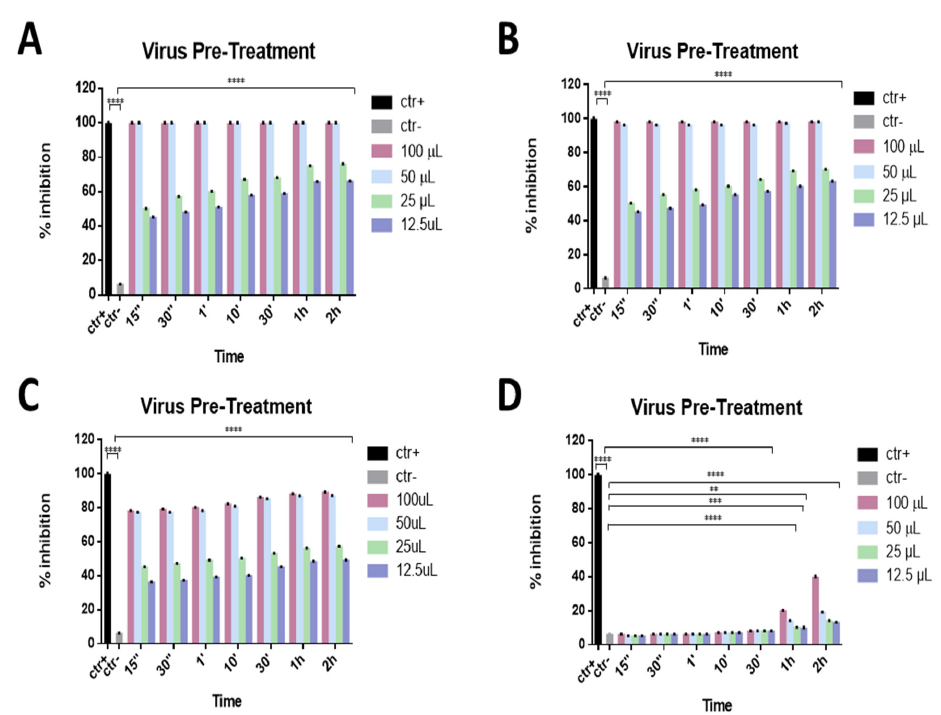
Figure 3. Virus pre-treatment assay. Antiviral activity against SARS-CoV-2 of eye drops at different times of stimulation. Iodim ( A ), Ozodrop ( B ), Dropsept ( C ), and Septavis ( D ) were incubated first with SARS-CoV-2 and then the mixture was titrated on Vero cells. Iodim, Ozodrop, and Dropsept inhibited the early stages of infection, while Septavis was not able to block the viral replication. ** p < 0.001; *** p = 0.0001; **** p < 0.0001; ns: non-significant.